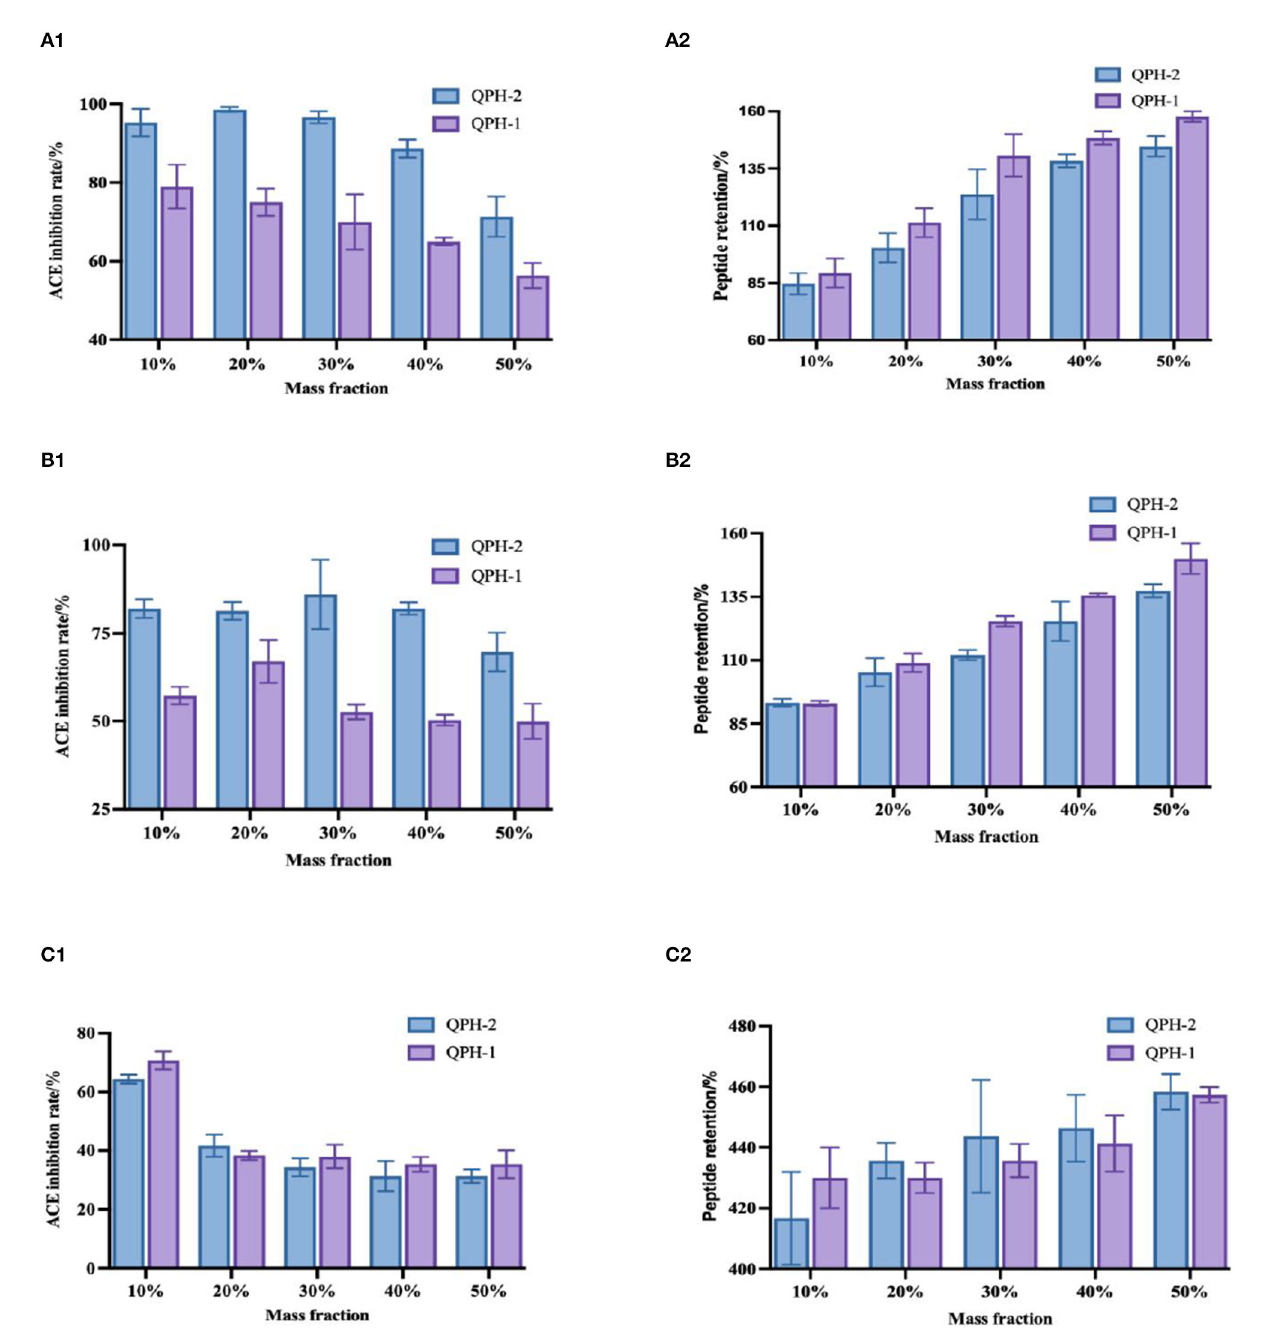
FIGURE8 (A1–C1) Shows the changes in ACE inhibition in the samples treated with different mass fractions of methanol, ethanol, and propanol, respectively. (A2–C2) Show the changes in peptide retention in the samples treated with different mass concentrations of methanol, ethanol, and propanol,